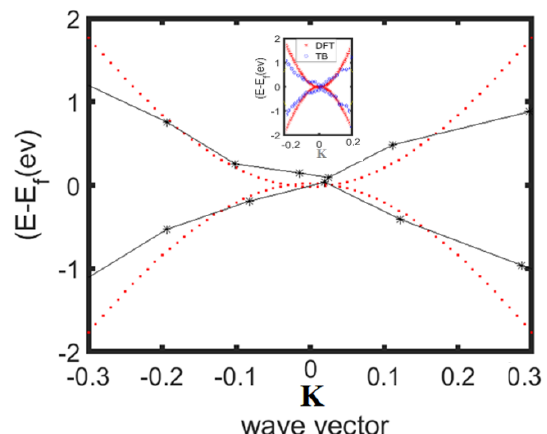
Figure 7. The comparison between the presented model (red dots) and density functional theory (DFT) simulation (black stars).